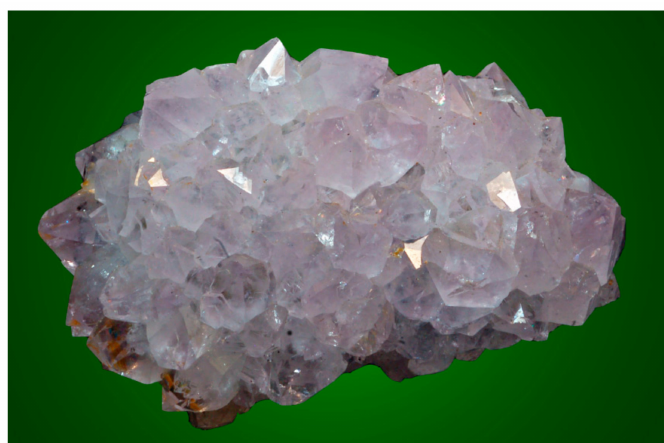
Figure 23. Quartz, variety amethyst, Toothaker Creek prospect. 5 cm. Chamberlain Collection, NYSM C7032. SN.